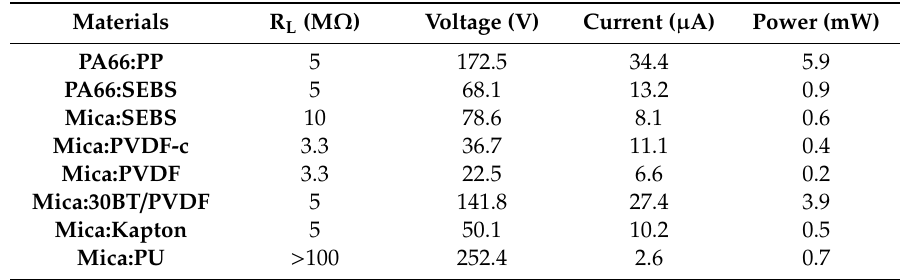
Table 2. Summary of the output power, voltage and current for the different systems under evaluation, the larger output powers being for the PA66:PP and the Mica:30BT/PVDF pairs. Materials R L (MΩ) Voltage (V) Current (µA)